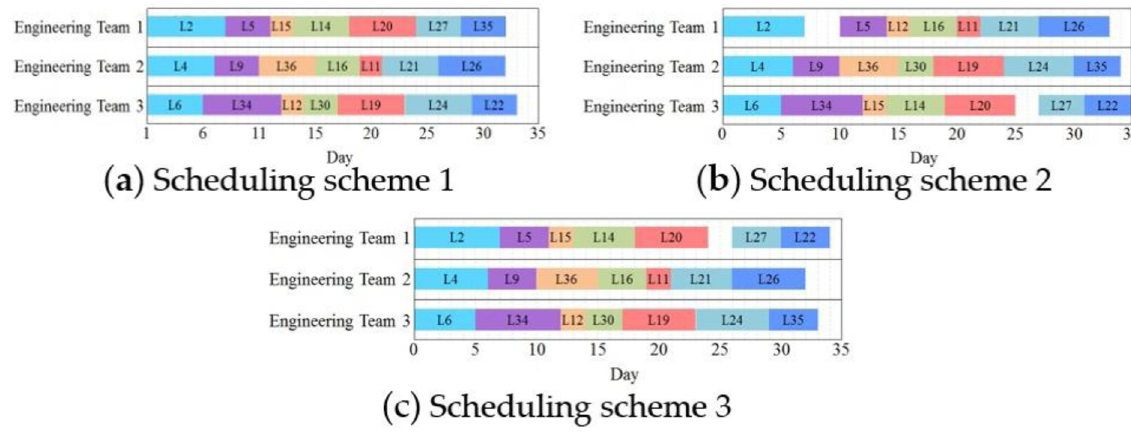
Fig 5. Three different highway maintenance scheduling schemes.